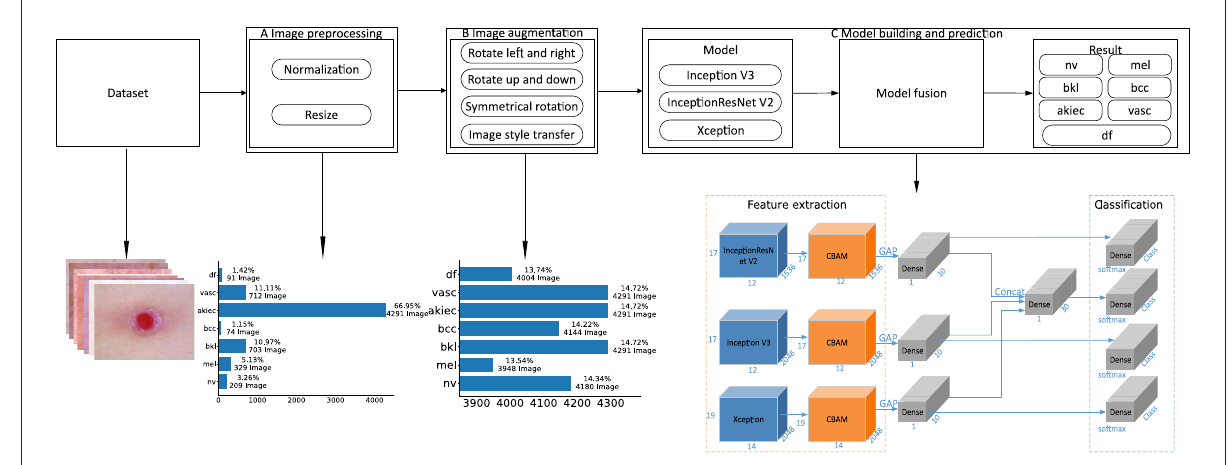
FIGURE1 An overview of the proposed method. (A) “Image preprocessing,” including image normalization and image resizing, is performed on an input image before feature extraction. (B) “Image augmentation,” including operations such as image rotation and image style transfer, performs upsampling on the input image to keep the various categories in a balanced state. (C) “Model building and prediction” carries out model training and prediction on the input image, wherein the feature extraction part is the fusion of three base classifiers and an attention mechanism [the convolutional block attention module (“CBAM”)], “GAP” denotes global average pooling, “Dense” is a fully connected layer, “Concat” is the fusion of the output results of the three branches, and “Class” is the number of categories. In this article, Class is 7. “Softmax” is the activation function of the classification output layer, “Classification” is the prediction result output layer, and the number represents the change in the characteristic dimensionality at each stage.